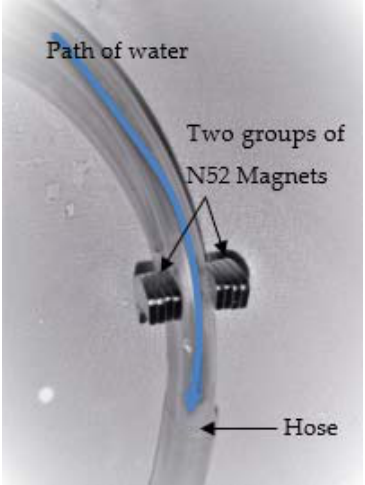
Figure 3. Neodymium magnetization process.